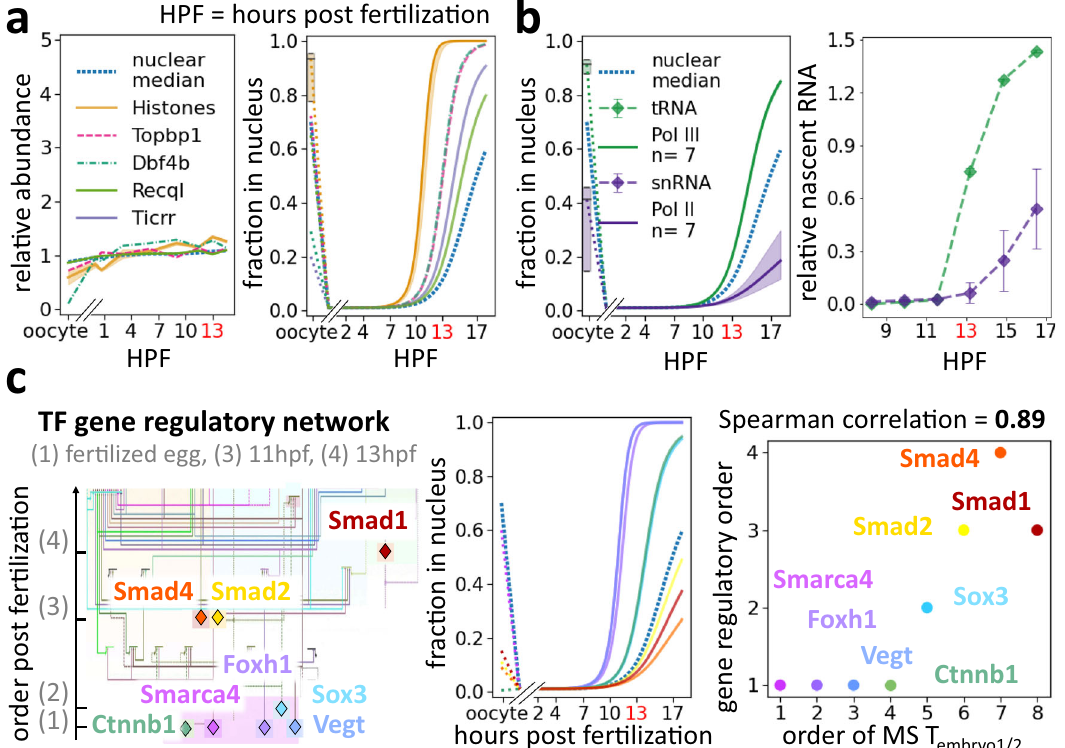
Fig. 3 | In early development, proteins enter nuclei sequentially correlating withtheonsetoftheirnuclearfunctions.a – c Embryosdevelopedat16°C. a Left: Protein abundance dynamics of previously reported ZGA key regulatory factors changelittlefromfertilizationtotheZGA 15,16 .Right:Theseregulatorsareamongthe earliest proteins to titrate into embryonic nuclei. Shown are fi ts of individual ZGA regulatorsand the median fi t of the core histones (H2a,H2b, H3, and H4) and their isoformswith50%spread. b RNApolymeraseIII(PolIII)andII(PolII)enternucleiat different times of development, which corresponds to the respective appearances of their fi rst downstream transcripts. Left: Proteomics data show that Pol III sub- unitstitrateintonucleibeforePolIIsubunits.Shownaremedianand50%spreadof uniquesubunits.Right:The fi rsttRNAtranscripts,transcribedbyPolIII,andsnRNA,